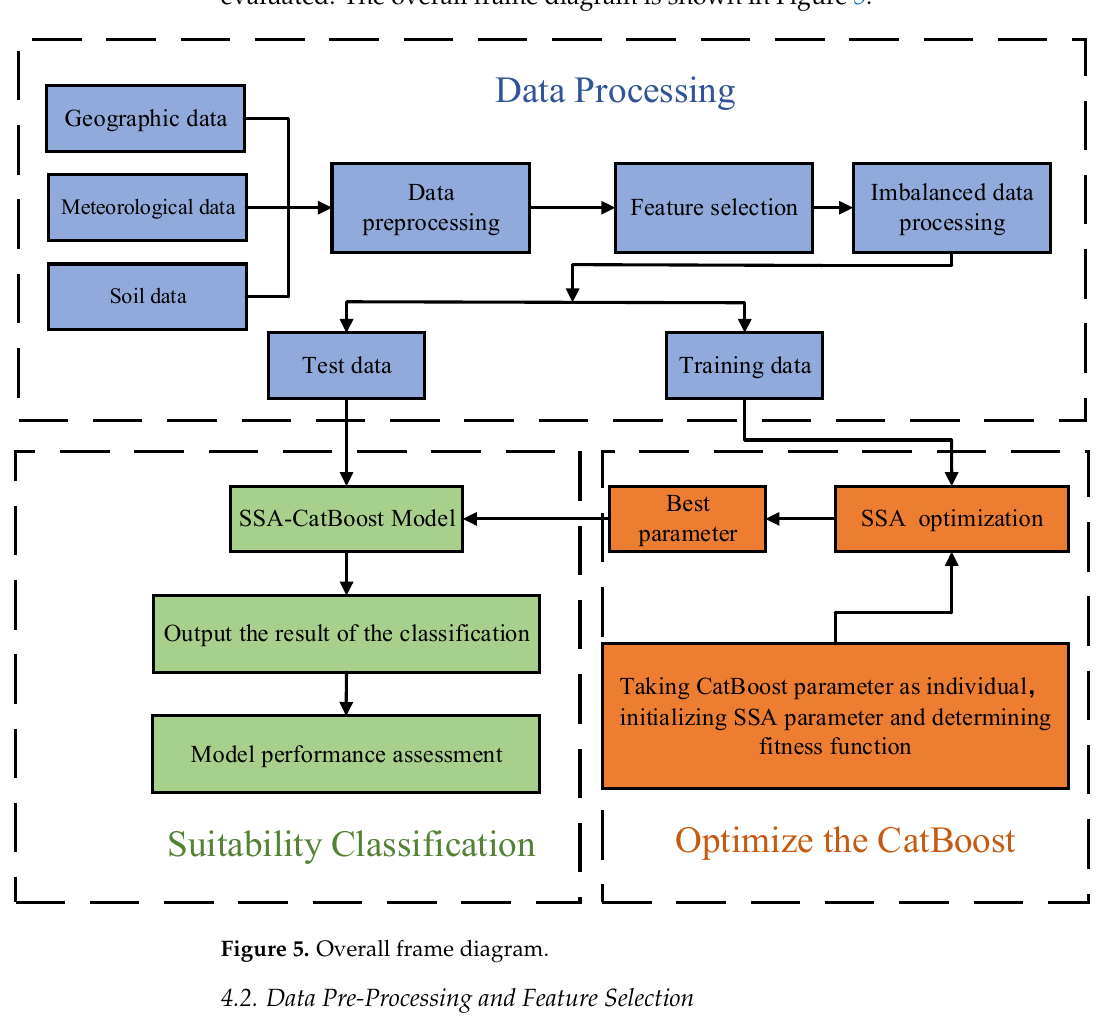
Figure 5. Overall frame diagram.